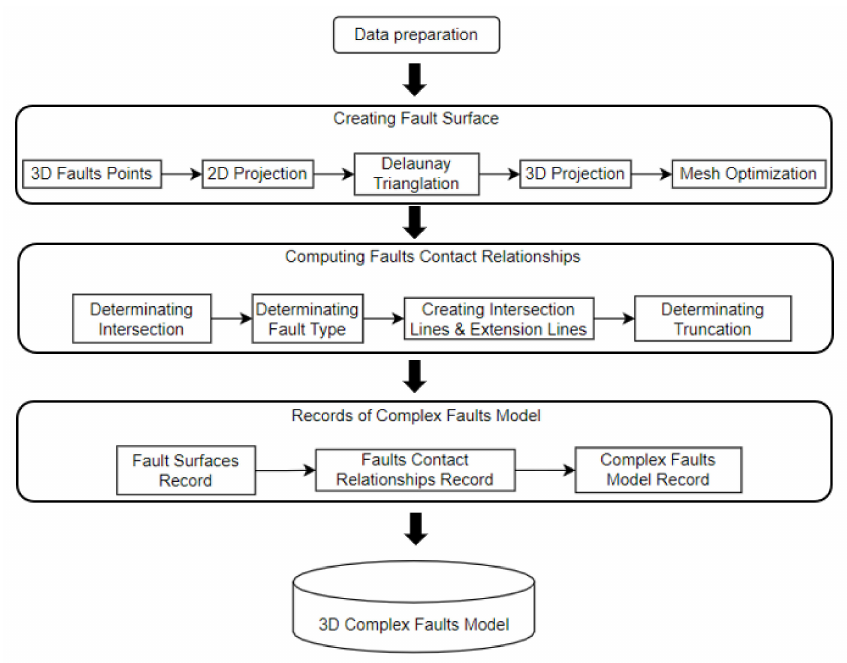
Figure 1. Flow chart of complex fault model